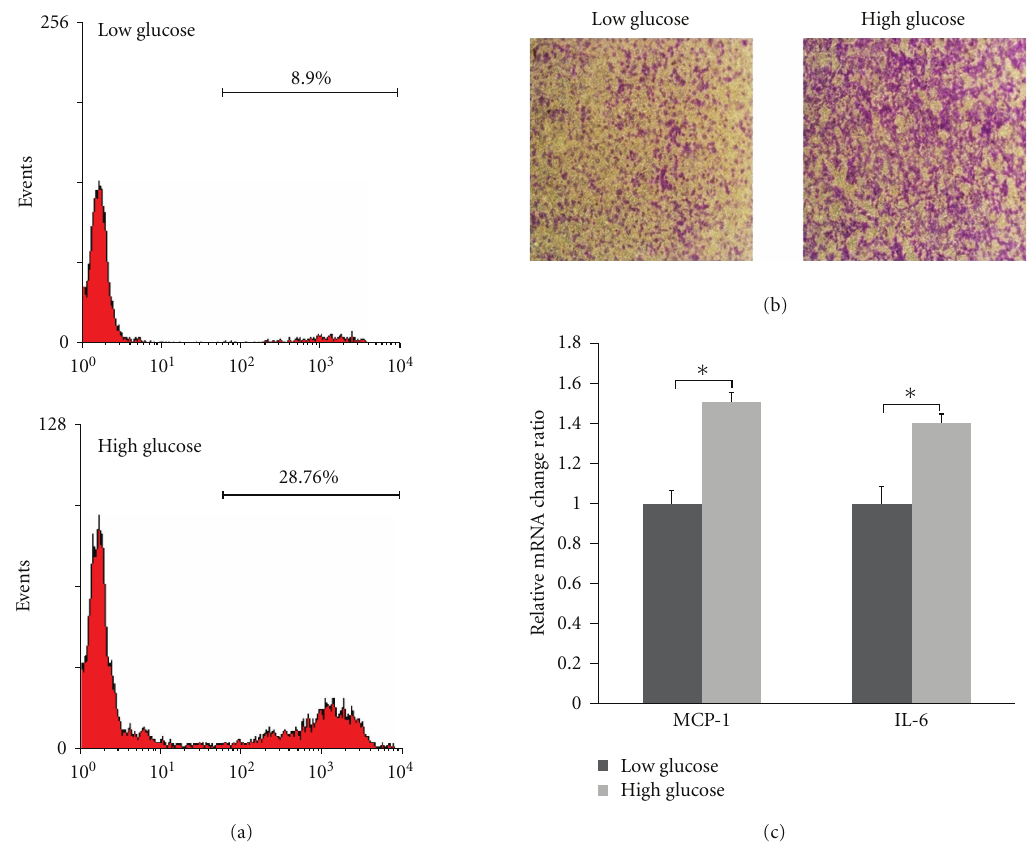
Figure 1: High glucose stimulated the proliferation, migration, and inflammatory gene expression of VSMCs. VSMCs cultured in low- glucose (5.5mmol/L) or high-glucose (25 mmol/L) complete media were deprived of serum for 24 h. In proliferation and inflammatory gene expression assays, VSMCs were stimulated by complete media for 6h, respectively. In migration assays, VSMCs were suspended, and then low-glucose or high-glucose complete media were added to the lower compartment respectively. (a) proliferation of VSMCs, (b) migration of VSMCs, and (c) inflammatory gene expression of VSMCs ( ∗ P < 0 .